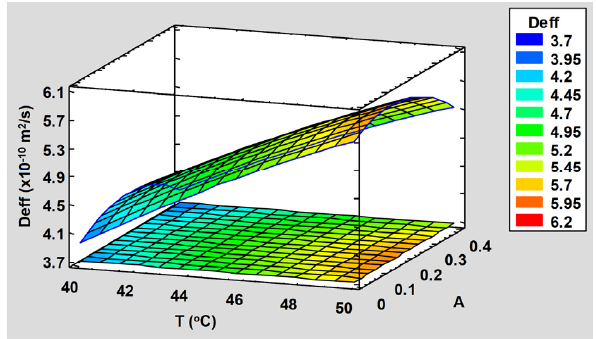
Figure 15. Effect of T and A on moisture diffusion coefficient Deff.